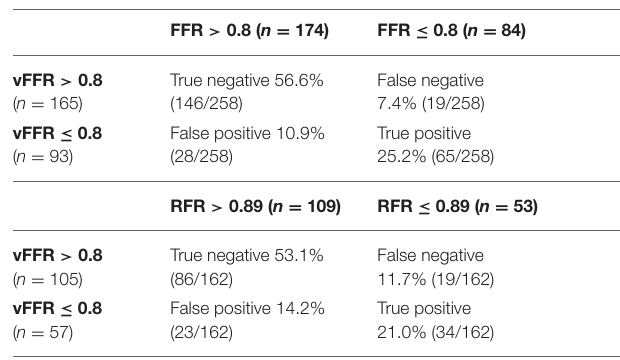
TABLE 3 | Diagnostic concordance between vFFR, FFR, and